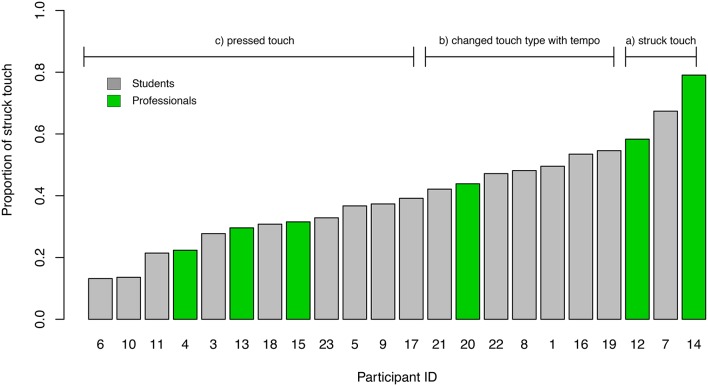
Proportion of struck touches for each participant. The gray bars indicate the participants who were students, the green bars label the professional performers. The participants were grouped by their touch types, according to the proportion of pressed touch and struck touch into three touch type groups.